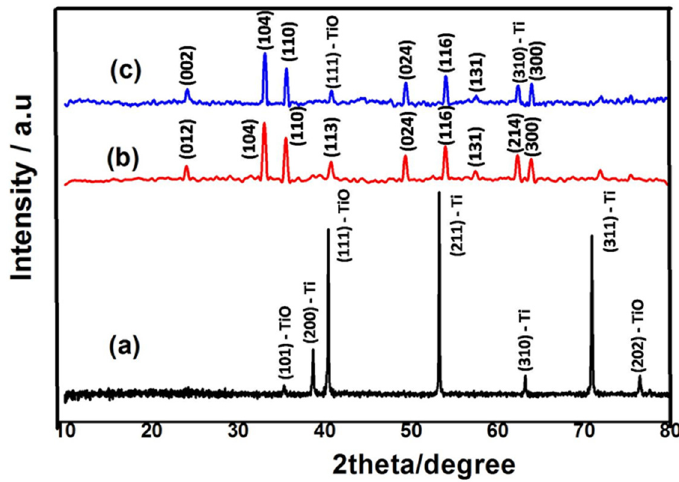
Figure 1. XRD patterns of TiO 2 nanorod ( a ), α -Fe 2 O 3 NPs ( b ), and FeTiO 3 ( c ).